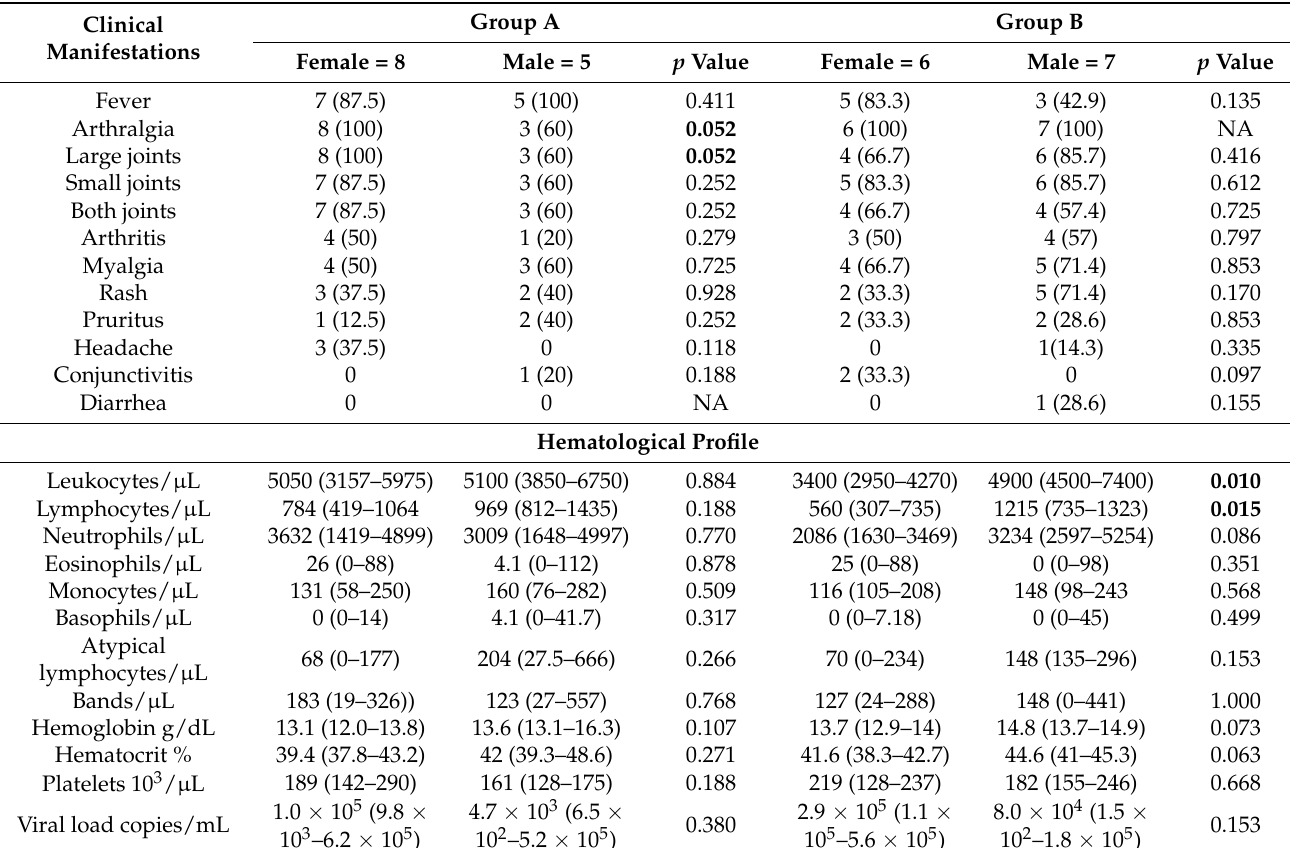
Table 1. Clinical and hematological profiles of the study cohort ( n =